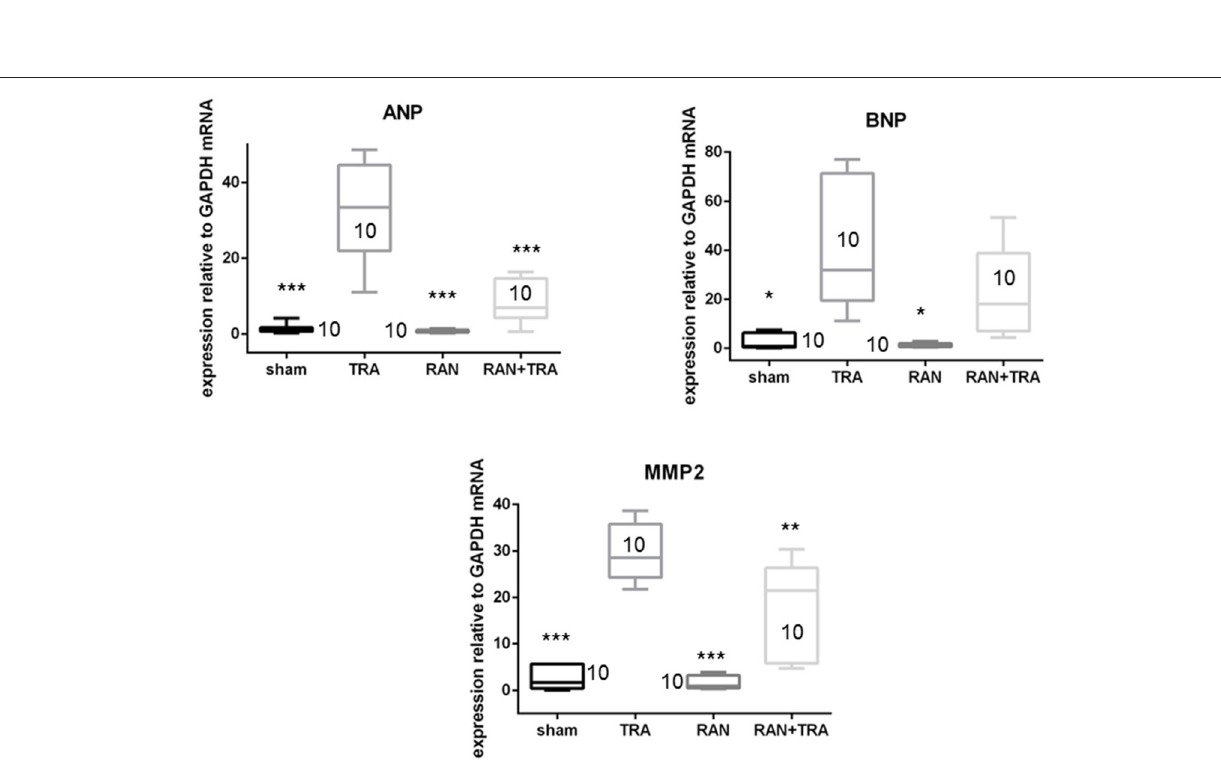
Frontiers in Physiology |